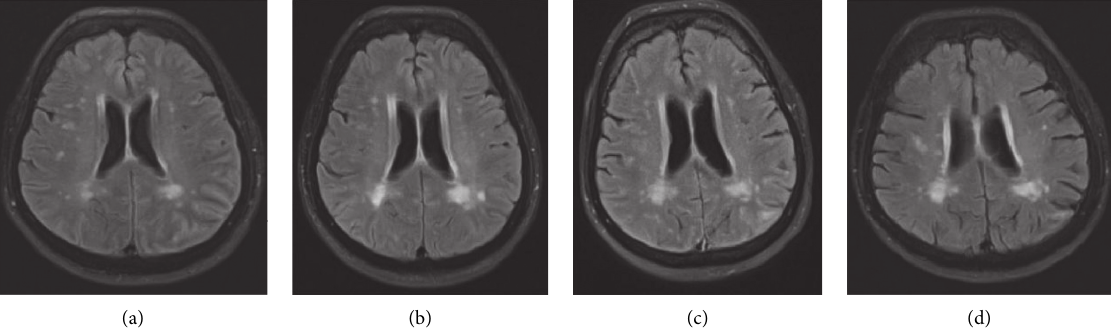
Figure 1: FLAIR images (a–d) showing progressive diffuse signal abnormality involving the white matter of both cerebral hemispheres over 7-year period (a–c) with gradual resolving after steroid treatment (d). (a) June 2012. (b) October 2012. (c) July 2019. (d) February